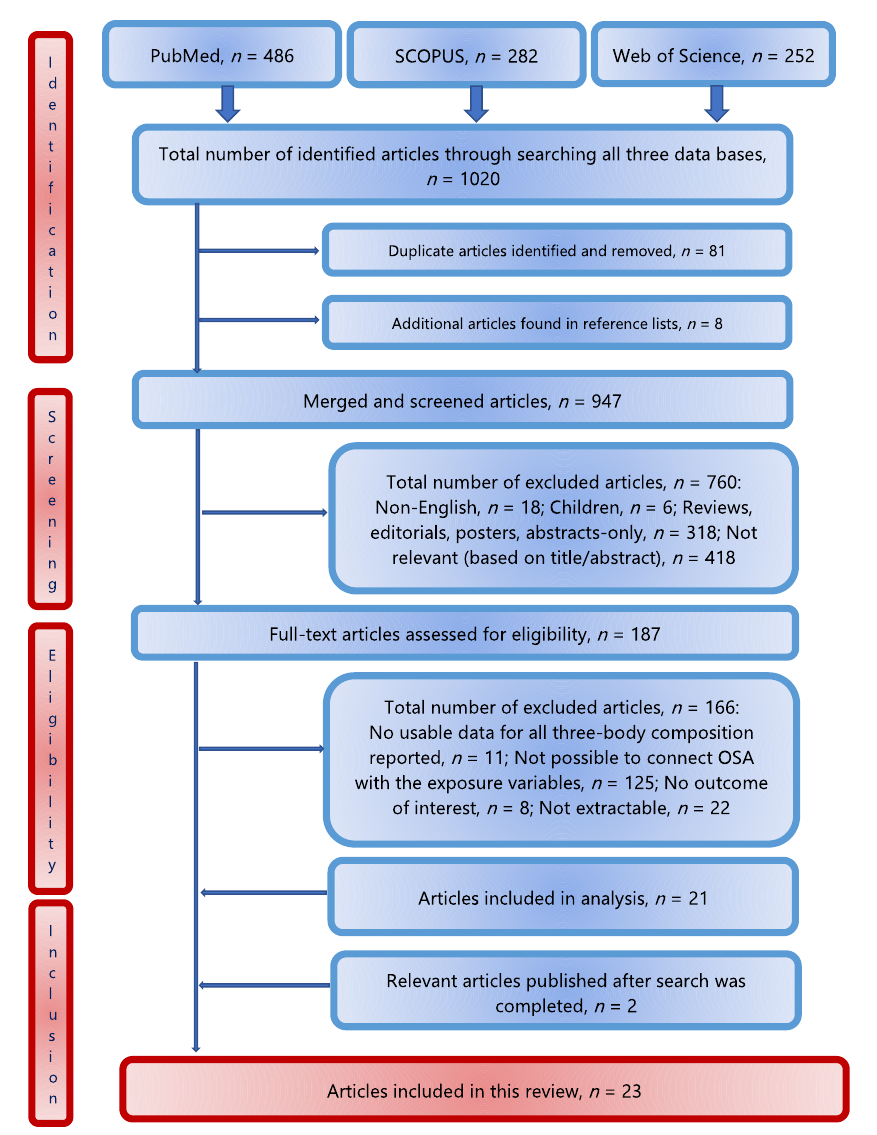
Figure 2. Flowchart (PRISMA) of the study selection Figure 2 . Flowchart (PRISMA) of the study selection process.